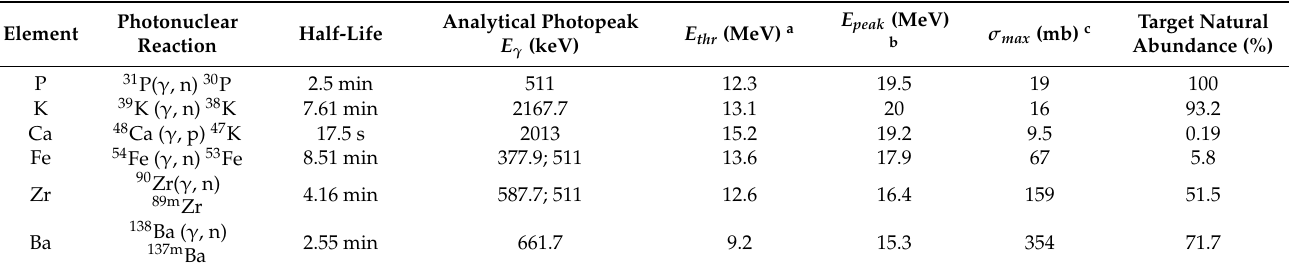
Figure 2. Components of the pneumatic tube delivery system installed at the MT-25 microtron. Left : 4-way routing head installed above the detector shielding with positions for sample insertion and delivery to the irradiation terminal (and back), counting position, and discarding position. Right : Sample in irradiation vial at the counting position on the detector inside the shielding.